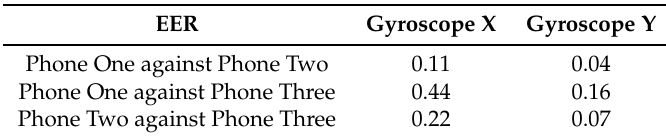
Table 5. EER for Gyroscope X and Gyroscope Y for a single day’s data in the second set of measurements